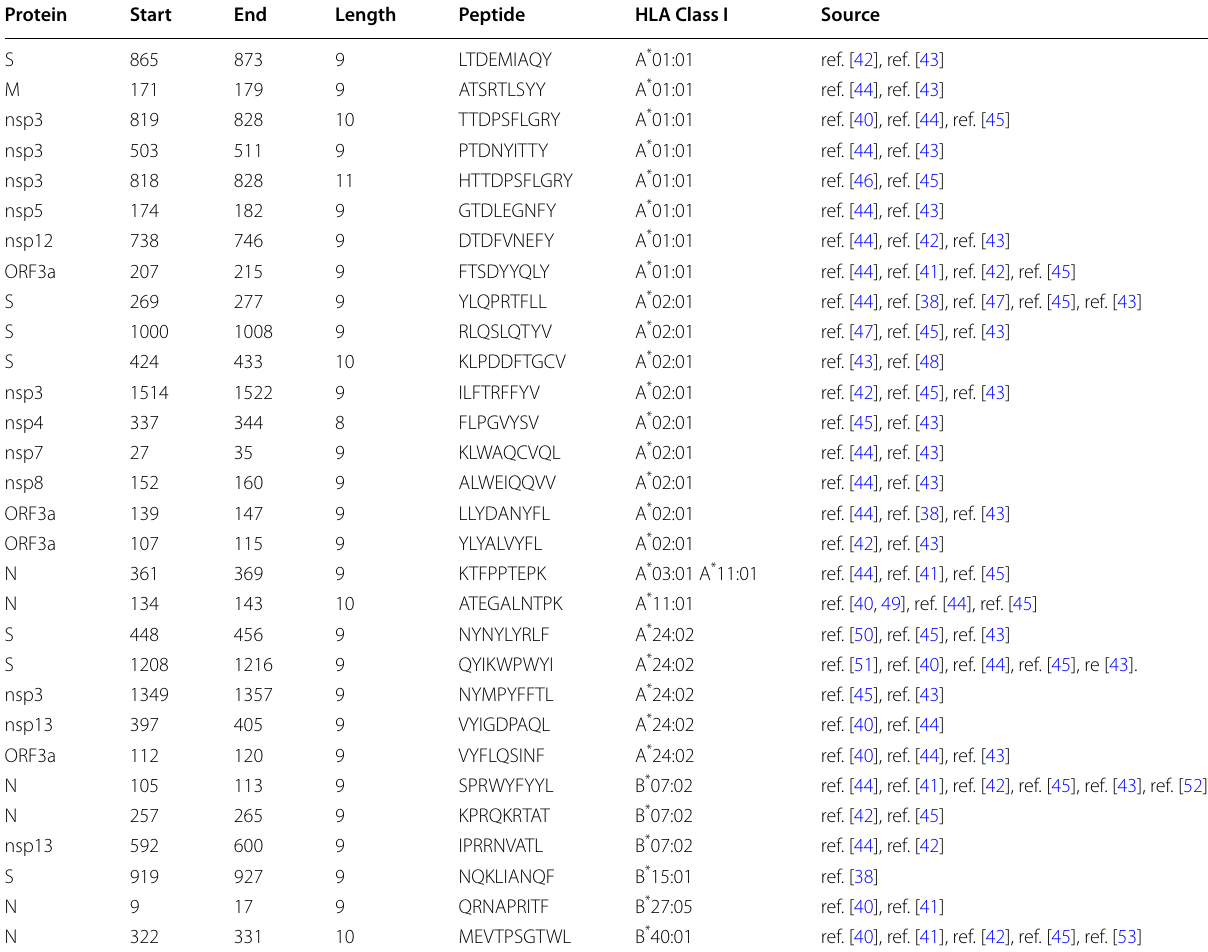
Table 1 Immunodominant peptides and associated HLA class I